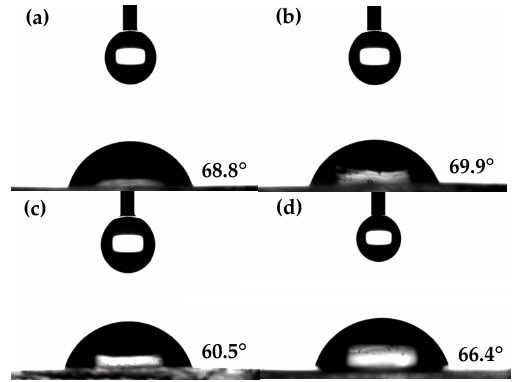
Figure 4. Contact angles of nanopure water droplets (4.5 μ L) on ( a ) low-methacrylamide chitosan (MC) hydrogel; ( b ) low-MC-gallic acid (GA) hydrogel; ( c ) high-MC hydrogel; and ( d ) high-MC-GA hydrogel.